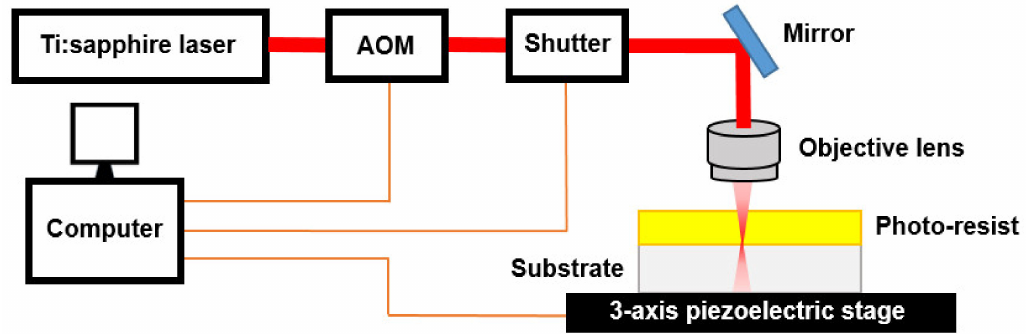
Figure 1. Schematic illustration of a typical MPL